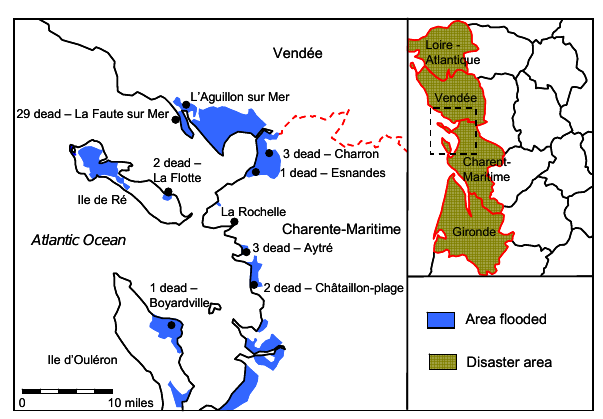
Fig. 3. Area flooded and the loss of life as the result of Xynthia in 2010. (Sources: Kolen et al., 2010, and Mercier andAcerra, 2011).